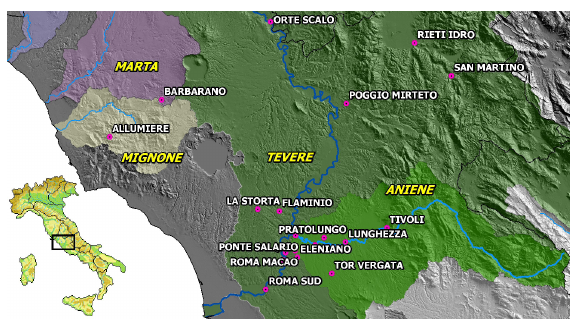
Fig. 2. Map of rain gauge stations in the low Tiber Valley, with indication of its geographic position in the Central Italy.